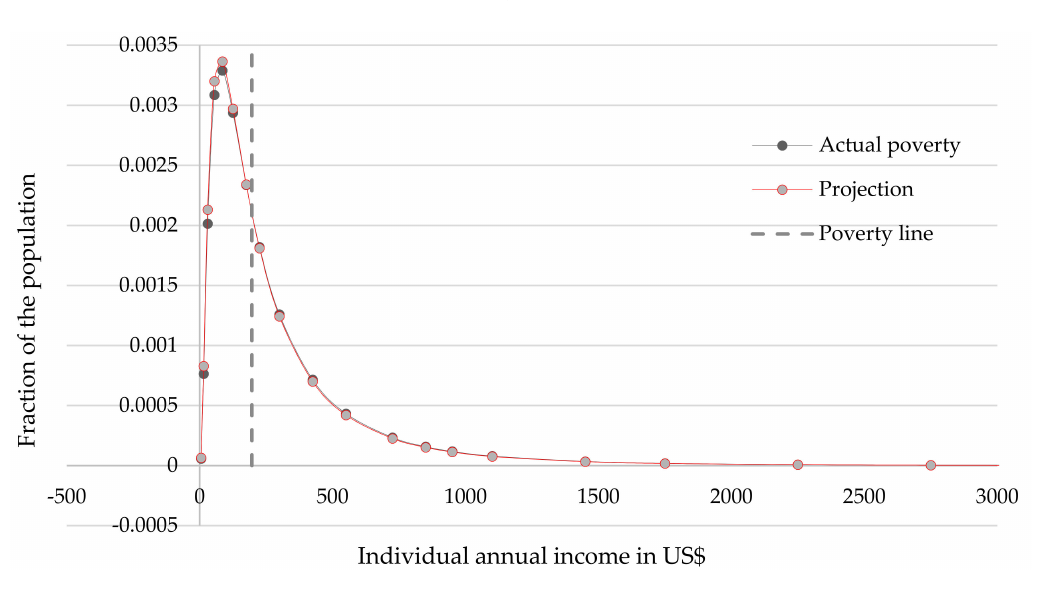
Figure 11. Annual per-capita income (US$) distribution of Mymensingh (17% loss of